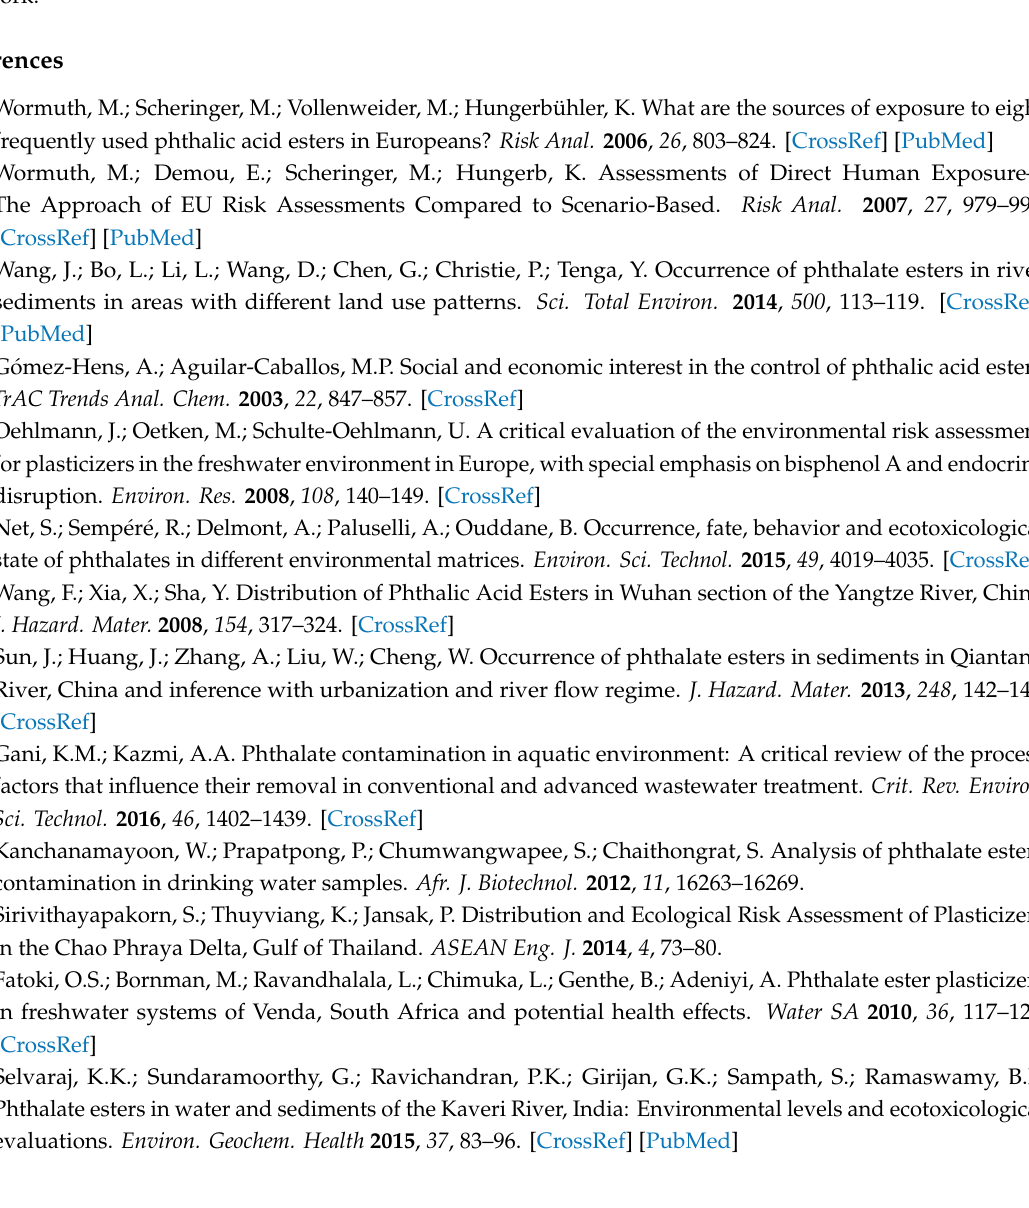
Figure S1: Chromatograph of DBP, BBP, DEHP, DnOP, DiNP and DIDP, Table S1: Toxicity of PAEs in some sensitive aquatic organisms, Table S2: Exposure factors used for health risk assessment, Table S3: QA / QC parameters for the extraction and analysis of six targeted PAEs, Table S4: comparing the validation of SPE and GC-MS methods used in this study with previous